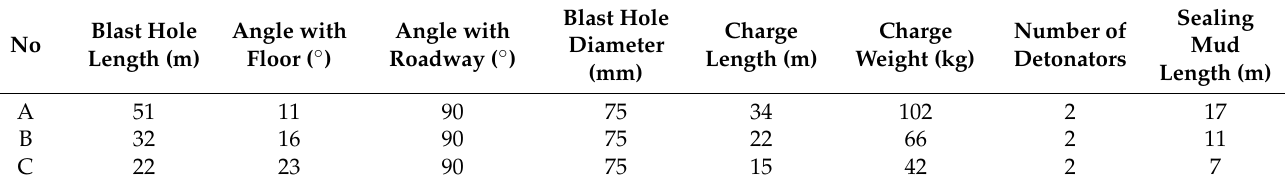
Table 2. Deep hole blasting parameters (Zone II).